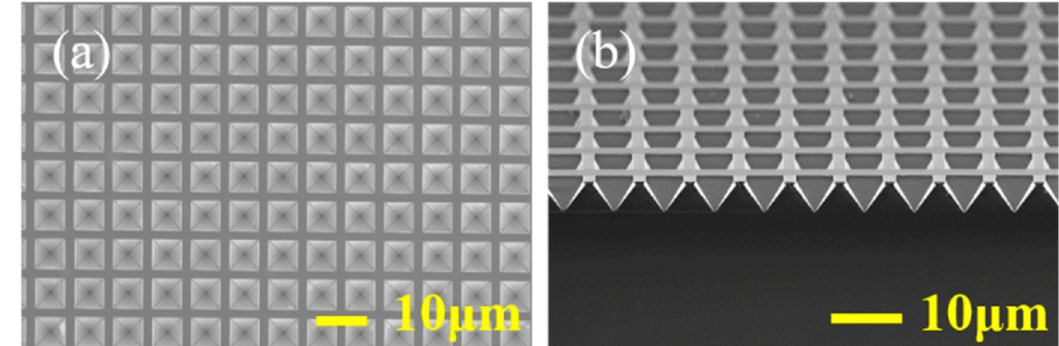
Figure 2. SEM images of the inverted pyramidal array images using anisotropic wet etching ( a ) top view, ( b ) cross section view.